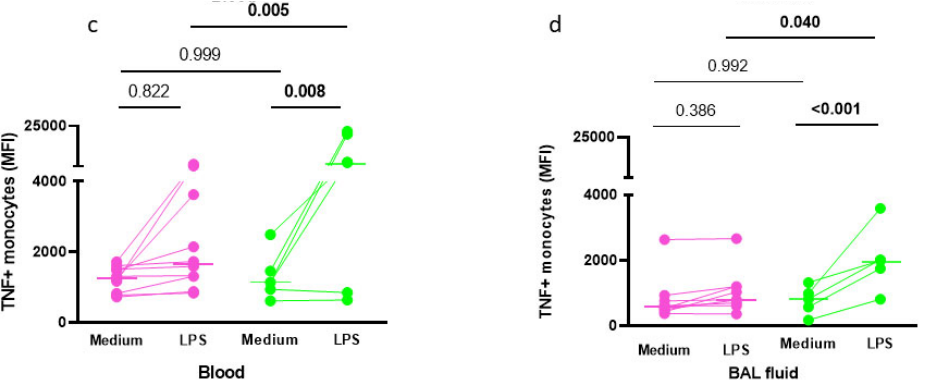
Figure 6. Alveolar and blood monocytes intracellular TNF expression. Intracellular expression of TNF by alveolar and blood monocytes was measured before (medium) and after (LPS) LPS challenge, and expressed in percentage of positive cells ( a , b ) and in mean fluorescence intensity (MFI) ( c , d ) in ten pneumonia-related ARDS (pink symbols) and seven non-ARDS (green symbols) patients. In blood monocytes ( a , c ), by two-way ANOVA with repeated measures, there was a significant effect of the experimental condition (medium vs. LPS, in percentage of positive cells, p = 0.003 ( a ) or MFI, p = 0.025 ( c )) and a significant effect of group (ARDS vs. non-ARDS, when expressed in MFI, p = 0.005 (c) but not in percentage of positive cells, p = 0.547 ( a )), as well as a significant interaction (experimental condition x group, when expressed in MFI, p = 0.027 (c), but not in % of positive cells, p = 0.516 ( a )). In BAL fluid monocytes ( b , d ), there was a significant effect of the experimental condition (medium vs. LPS, in percentage ( b ) ( p < 0.001) and MFI_( d ) ( p = 0.015)), no significant effect of group (ARDS vs. non-ARDS), either in percentage ( b ) ( p = 0.114) or MFI ( d ) ( p = 0.106), and a significant interaction (experimental condition x group) when expressed in percentage of positive cells ( b ) ( p = 0.023) but not when expressed in MFI ( d ) ( p = 0.078). Displayed p -values come from post-hoc comparisons performed using the Sidak’s test. Horizontal bars represent median values.